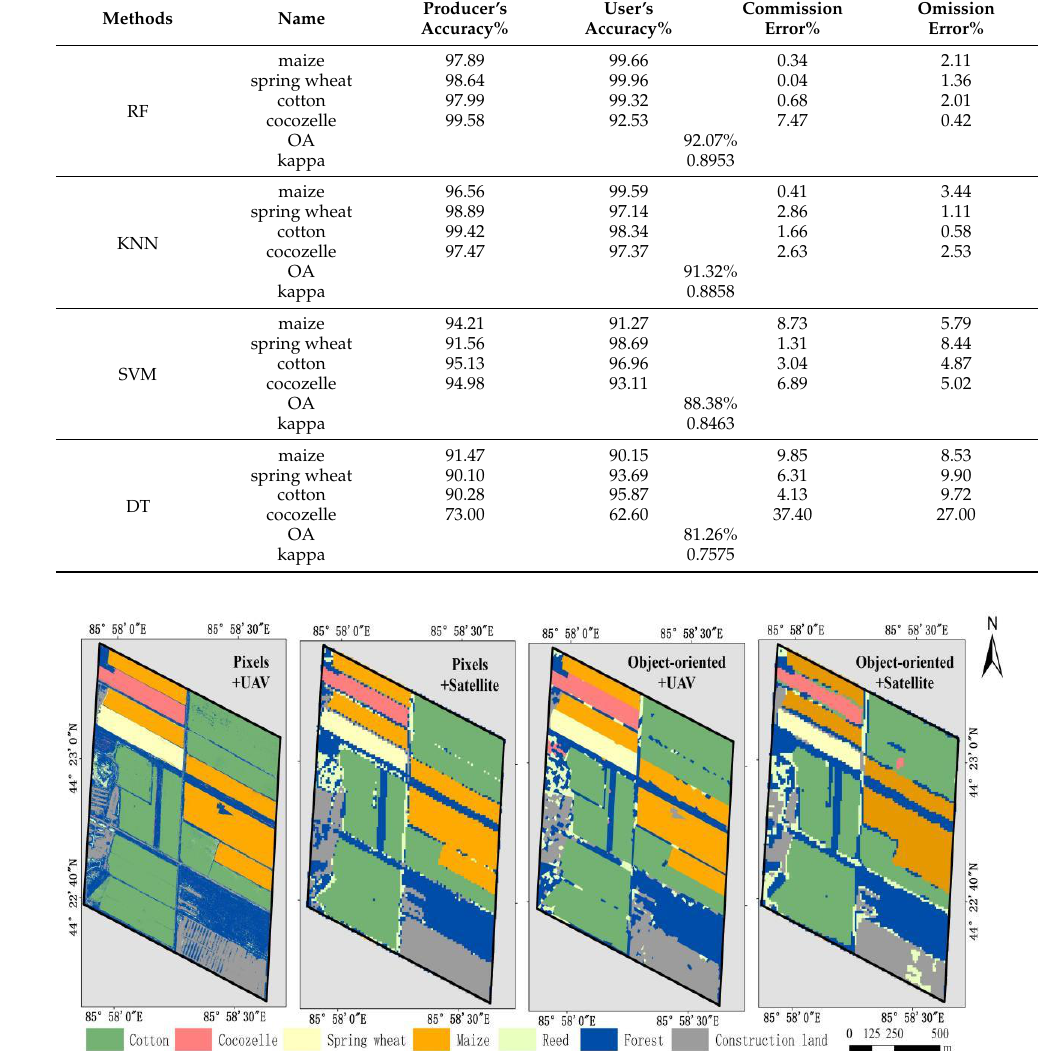
Figure 11. Crop classification results of different image types and different classification methods.